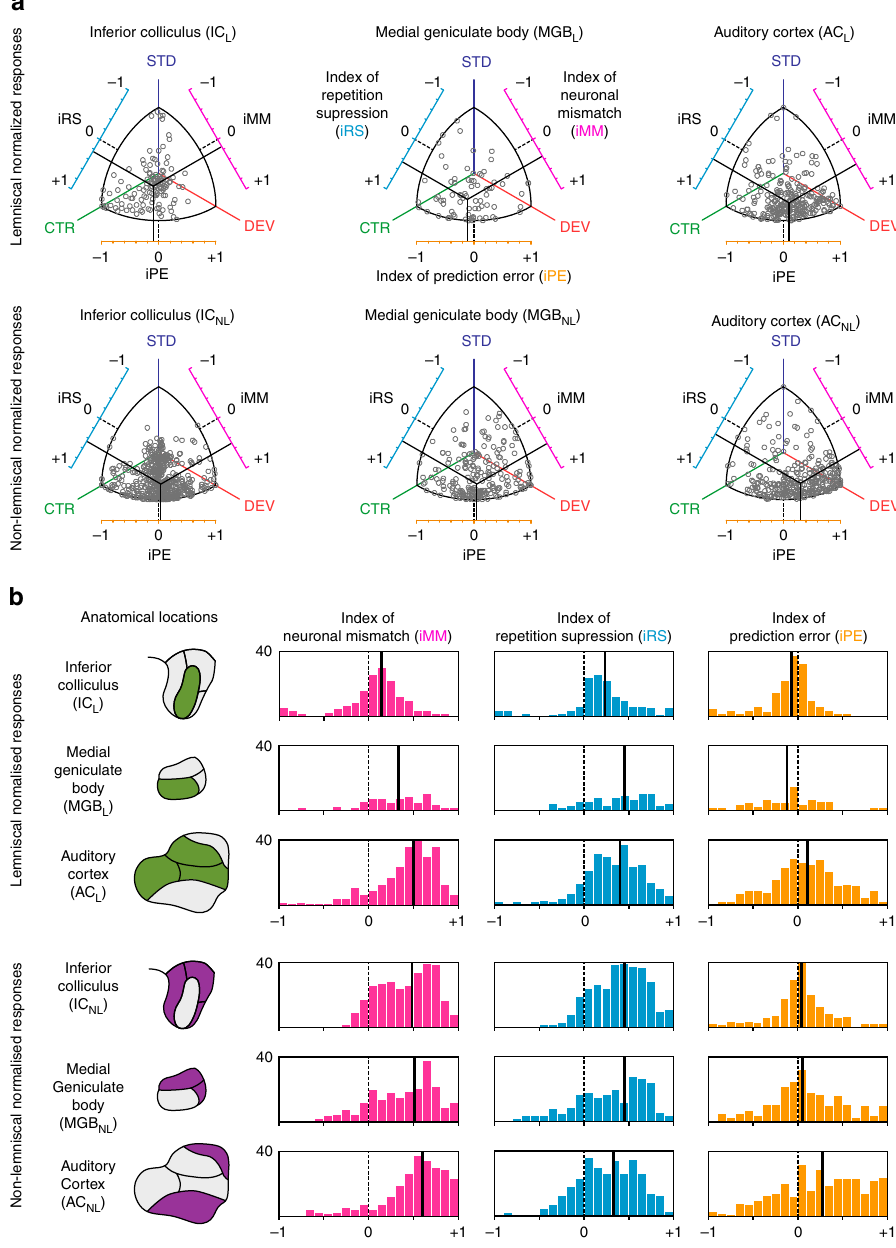
Fig. 3 Prediction error at population level for each station in anaesthetized rat. Distribution of normalized responses and related indices of neuronal mismatch (iMM), repetition suppression (iRS) and prediction error (iPE). a Each grey dot in these scatter plots represents the three normalized responses of a single neuron to the same tone played as deviant (DEV), as standard (STD) and as control (CTR). Indexes result from the difference between two of these normalized responses, represented in the axes surrounding the scatter plots, where the dotted black lines marks the absence of difference between conditions (index = 0). Solid black lines represent the mean of each index, corresponding their intersection to the center of gravity of the distribution of responses in the normalized space. Note how, while the intersection for lemniscal subcortical stations (IC L and MGB L ) is skewed towards CTR, in their non- lemniscal counterparts (IC NL and MGB NL ) as well as all over the cortex (AC L and AC NL ) the center of gravity of the distribution shifts closer and closer to DEV as it moves up in the auditory pathway, increasing the iPE as auditory information reaches higher-order stations. b Histograms represent distributions within stations of the three indexes for each neuronal response. Solid black lines indicate medians. The noticeable overall tendency of the median indexes to shift towards more positive values, from IC through MGB to AC, and from lemniscal to non-lemniscal divisions, unveils a hierarchy of processing in